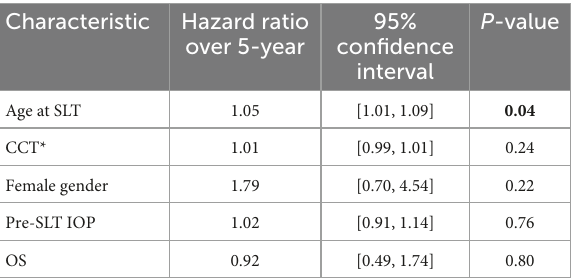
TABLE 3 Summary of hazard ratio